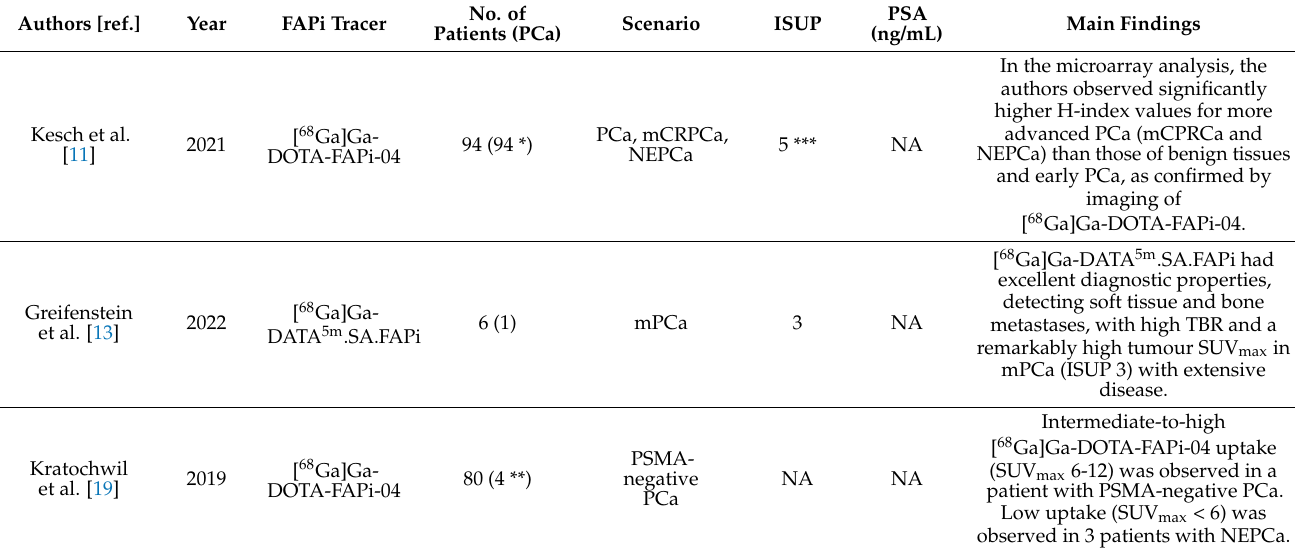
Table 1. R é sum é of the described studies on FAPi IHC biodistribution for